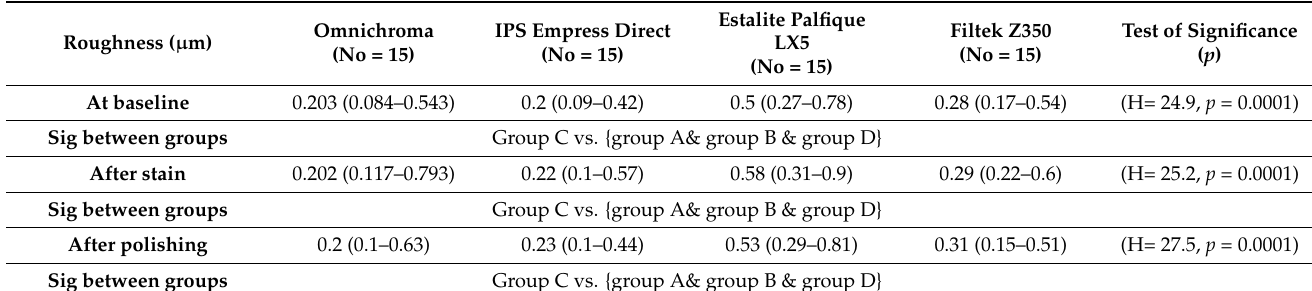
Table 5. Roughness comparison between